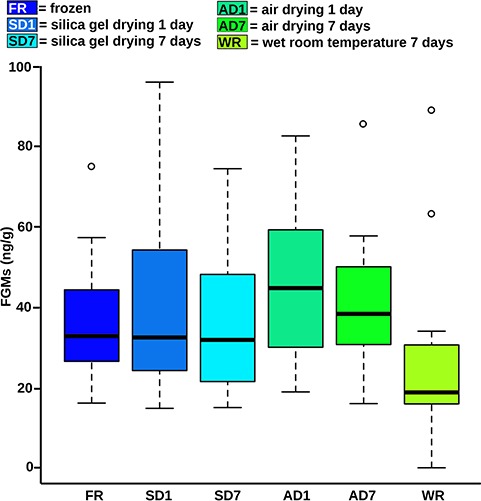
Concentrations of FGMs. The whisker boxplots depict the data of the particular preservation method. The line in the box represents the median and the circles above the box represent outliers. For full statistical data, see Supplementary File S4.